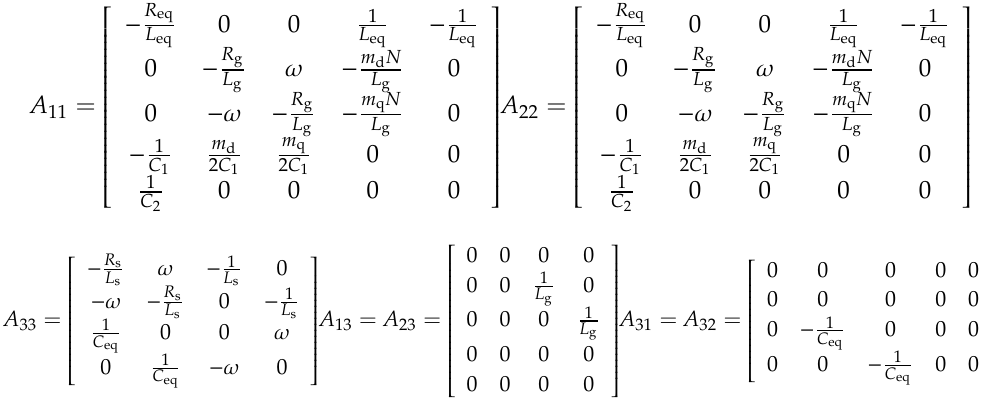
Figure 11. The waveform of input dc bus voltage (contrast model).